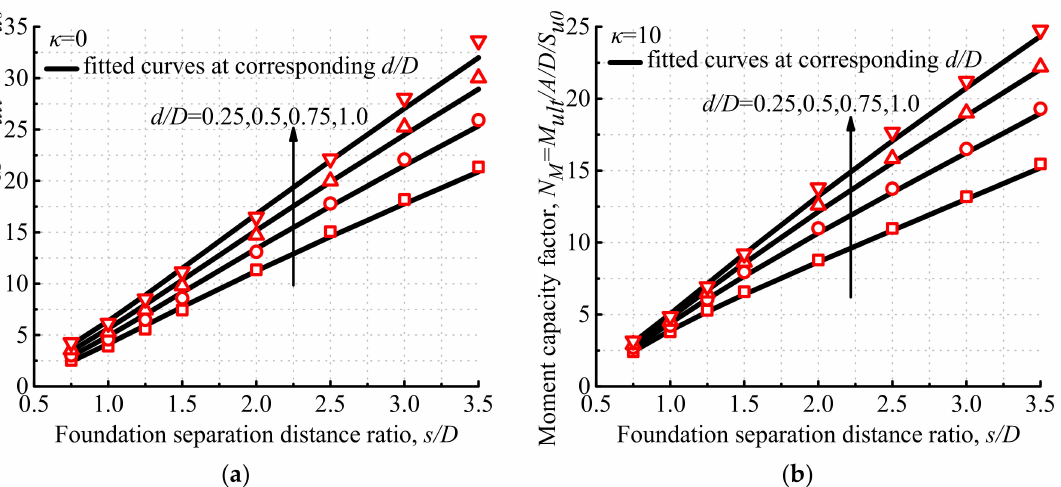
Figure 21. Comparisons of moment capacity factors for tetrapod bucket foundations between finite- element results and fitted curves with various d/D when ( a ) κ = 0 and ϕ = 0, and ( b ) κ = 10 and ϕ =